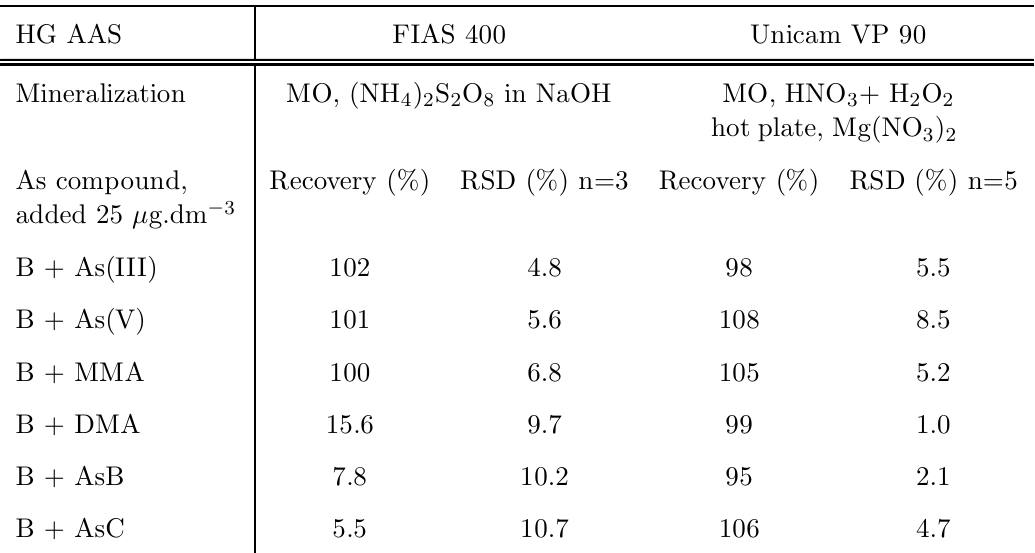
Table 4 Recovery of As in blood by HGAAS after di¬erent mineralization procedures. Control sample B (Seronorm